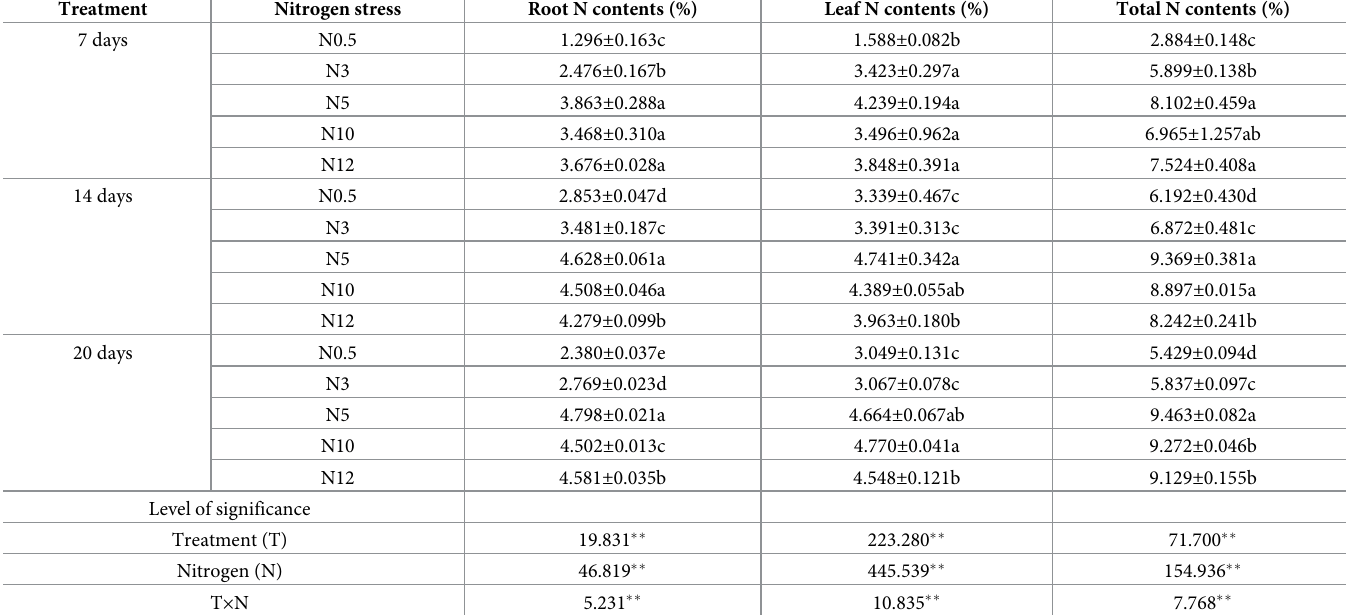
Table 4. Effects of nitrogen treatments on nitrogen content of sugar beet seedlings.